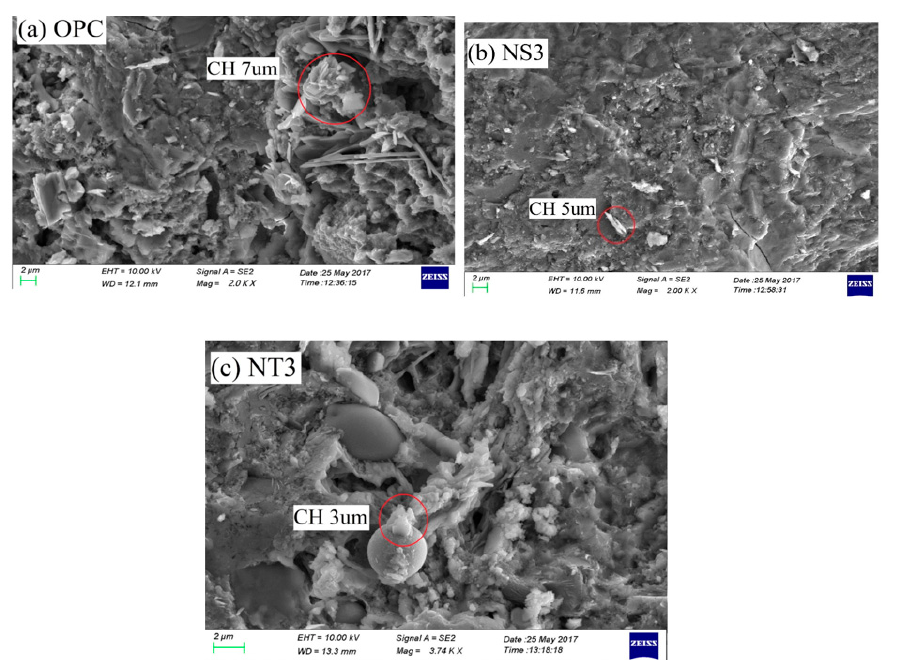
Figure 4. Surface morphology of cement ( a ) pure, ( b ) with 3% nanosilica, and ( c ) with 3% nano- titanium [65]. Table 1. Effects of NPs on cementitious fresh, strength, and durability performance.